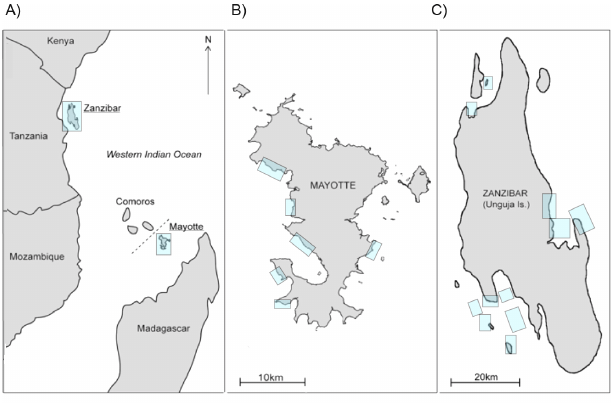
Fig. 1 . Maps showing (A) location of study sites, and higher detail of (B) the island of Mayotte (12°50 ′ S, 45°8 ′ E) and (C) Zanzibar (Unguja Island; 6°8 ′ S, 39°19 ′ E). Sampling areas are indicated with shaded